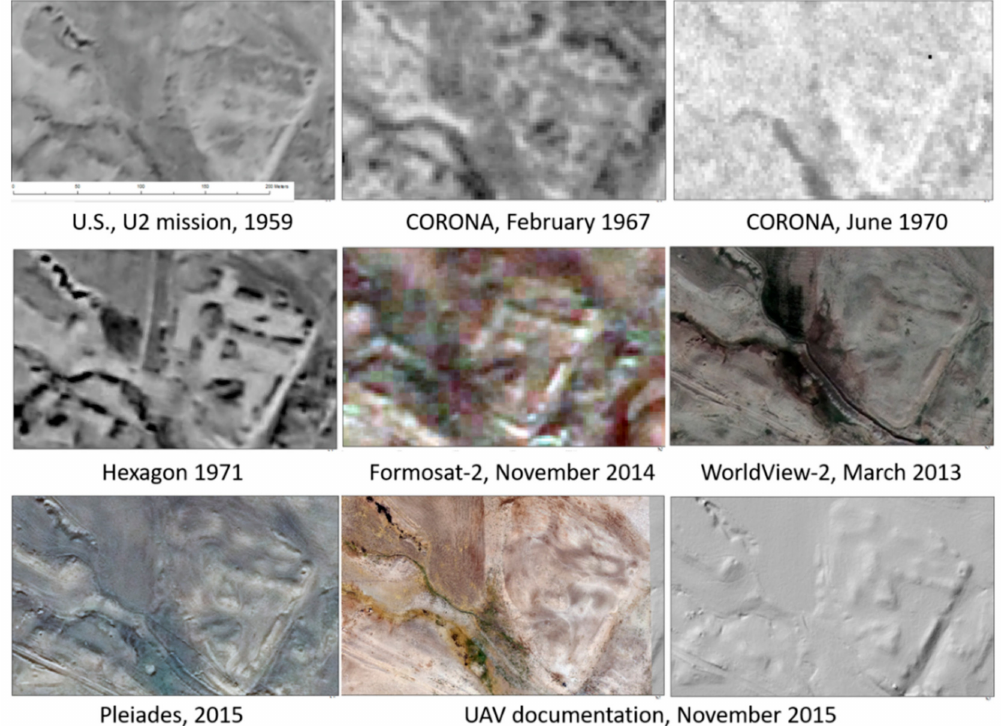
Figure 7. Overview of historical and modern remote sensing data used to document the Kona Makhm¯ur site—comparison of feature visibility (author: Lenka Starkov á